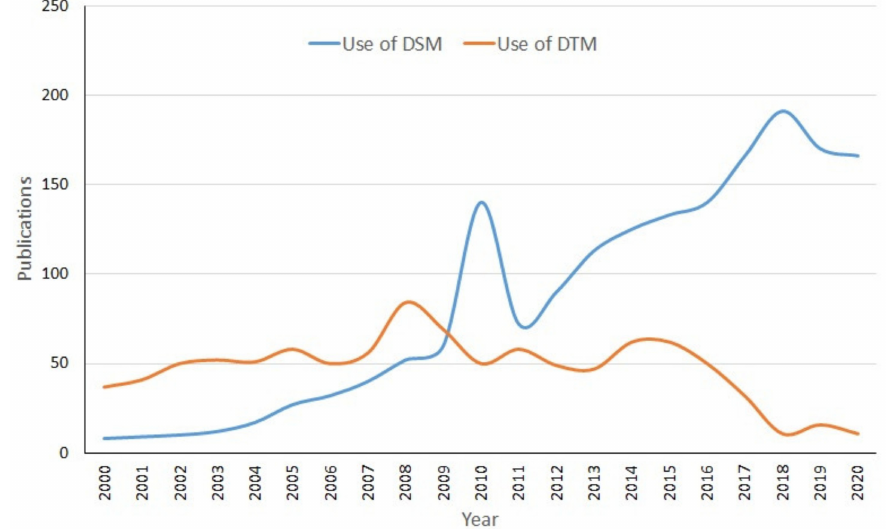
Figure 1. Differences in the use of digital elevation models compared to digital surface models in articles published in scientific journals. Data obtained from Google